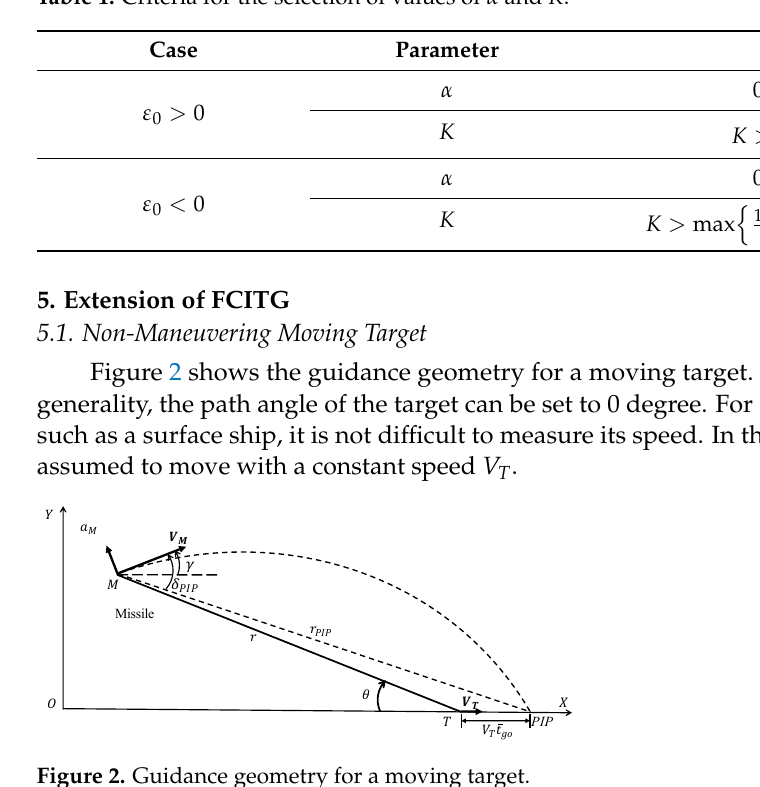
Table 1. Criteria for the selection of values of  and K .